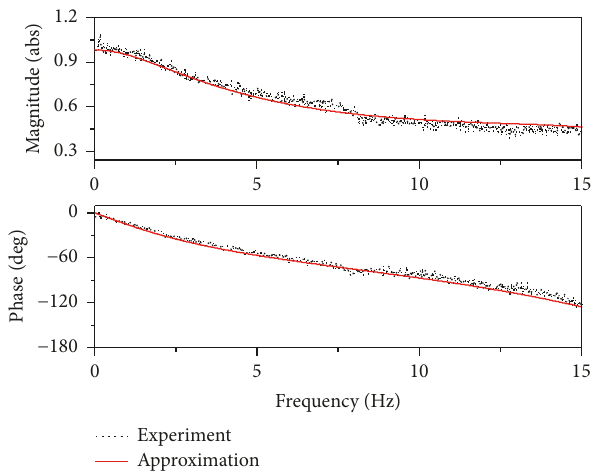
Figure 9: Comparison of the experimental and approximated transfer functions of shaking